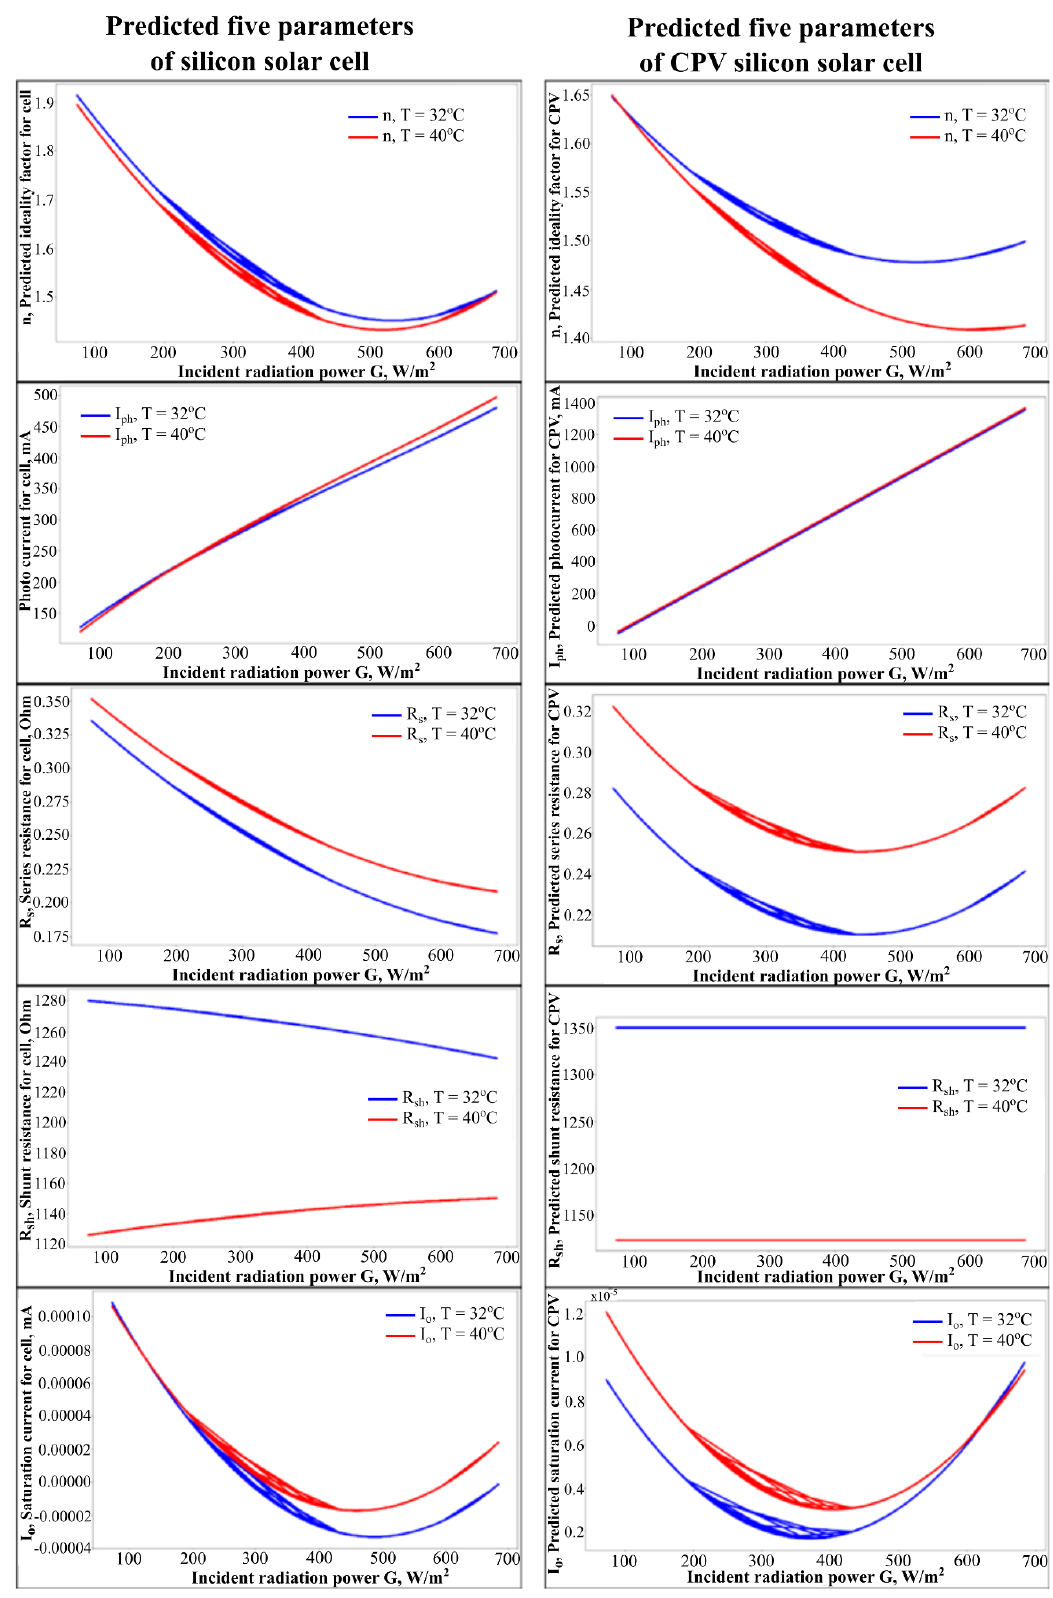
Figure 10. Approximation of the parameters of a silicon solar cell and LCPV at temperatures of 32 °C and 40 °C.